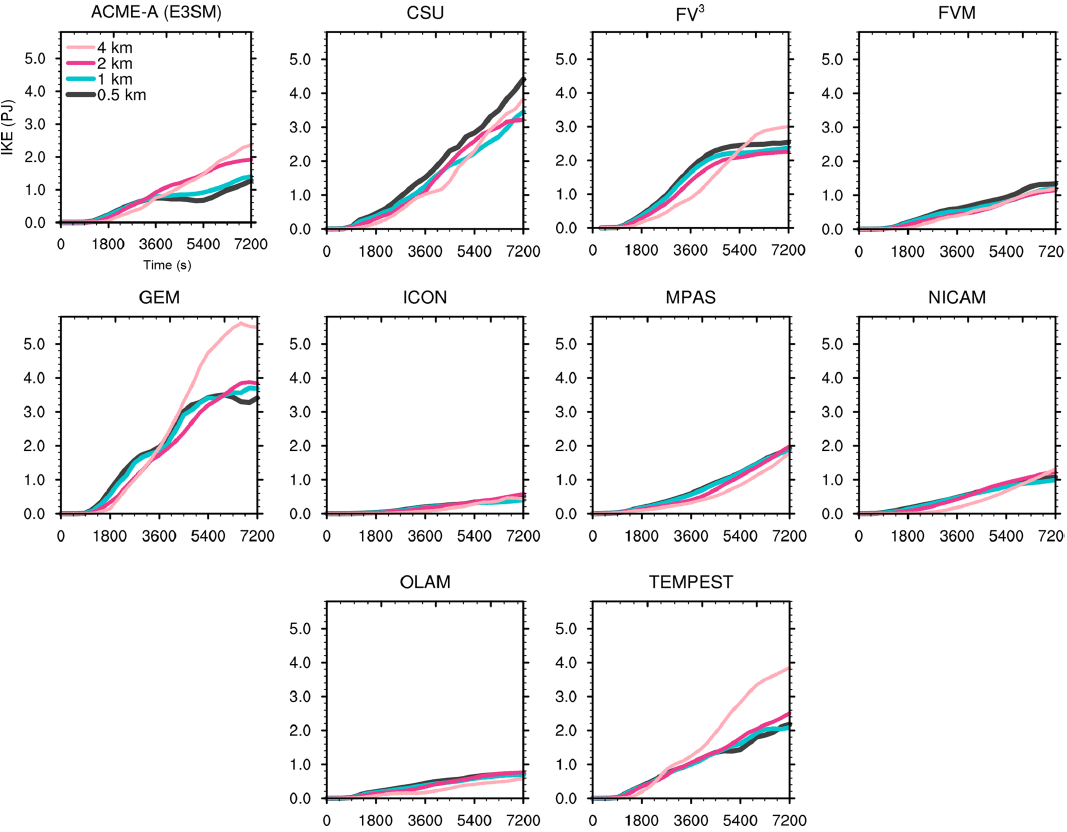
Figure 7. Same as Fig. 5 except showing storm-integrated kinetic energy (PJ) as defined in Eq. (20).